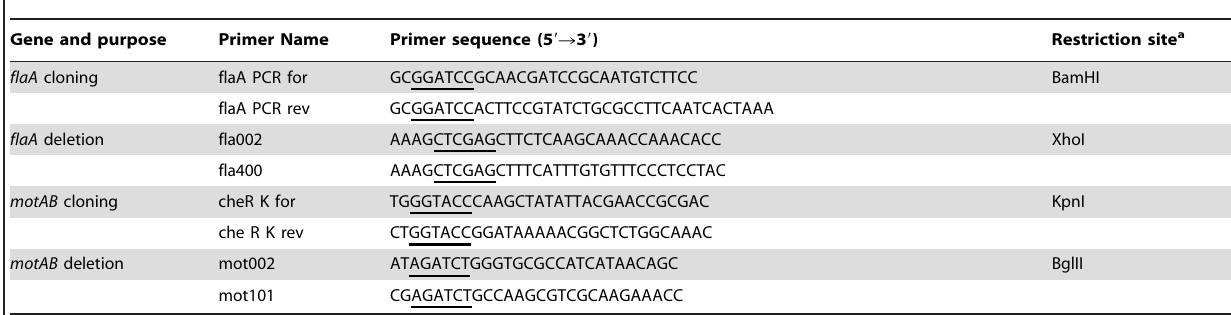
Table 5. PCR primers used in this